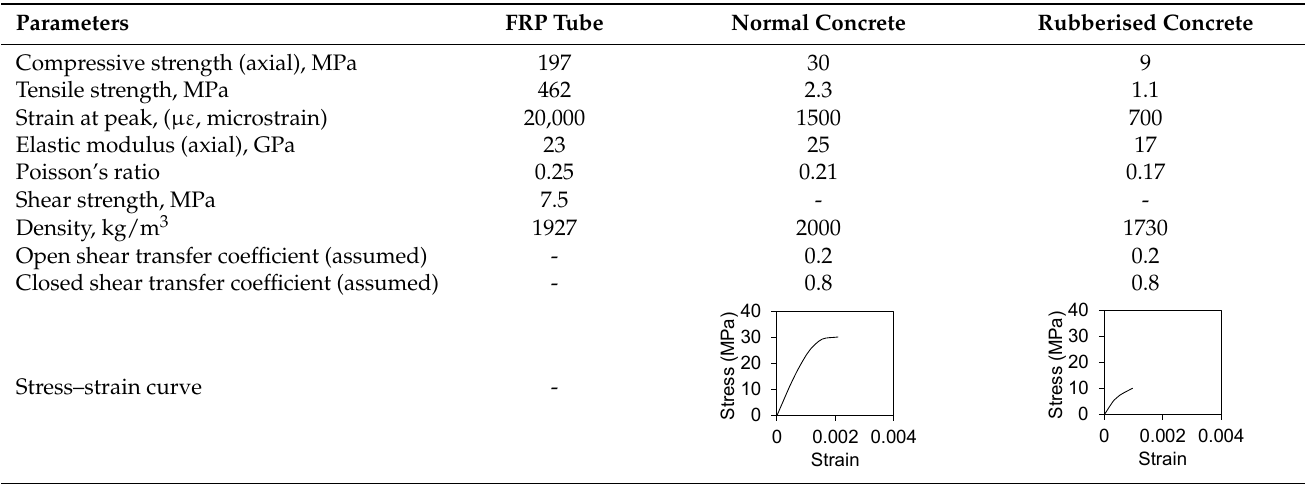
Table 1. Properties of materials.